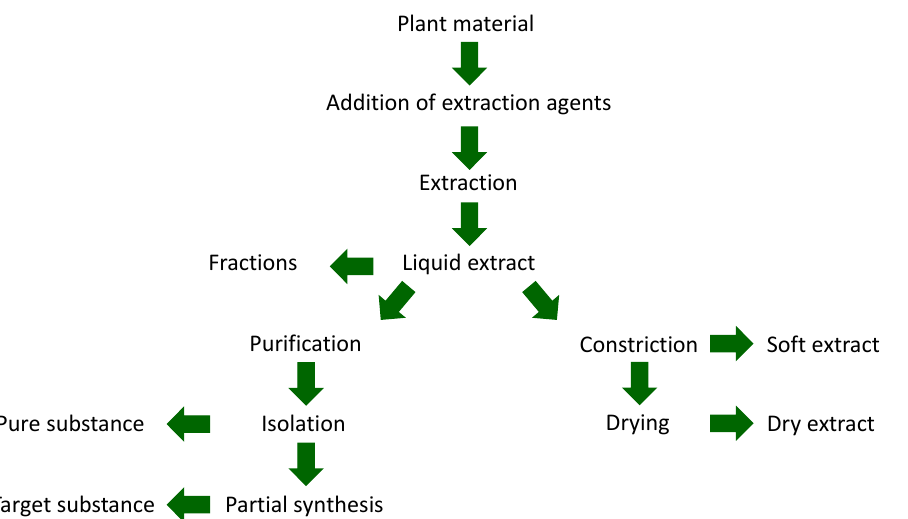
Figure 1. The process cascade for providing extracts and (modified) pure substances from plants.